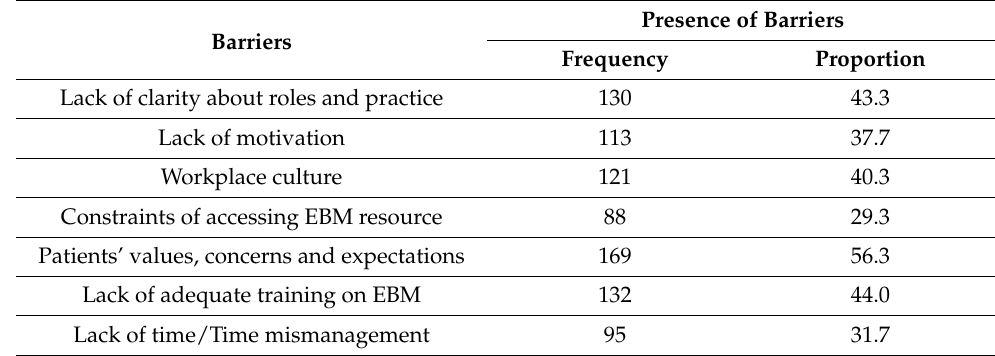
Table 7. Barriers to evidence-based practice (n =